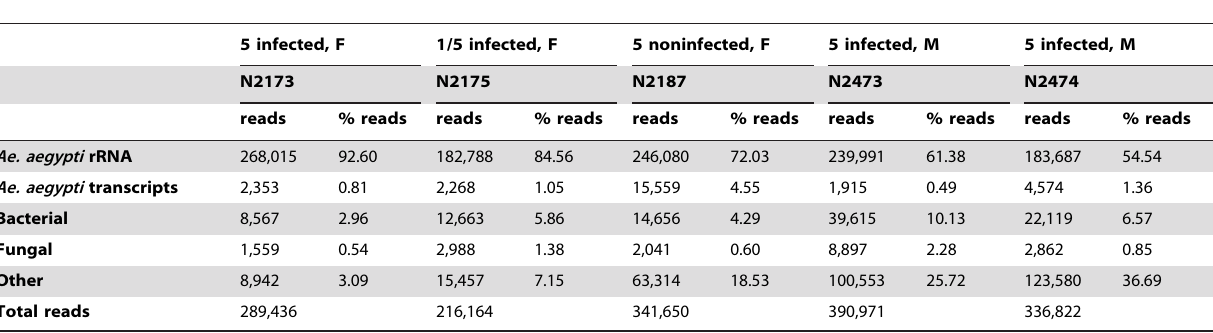
Table 1. Major constituents of Ae. aegypti metagenome are listed below, with number of reads corresponding to each category as well as percentage of the total